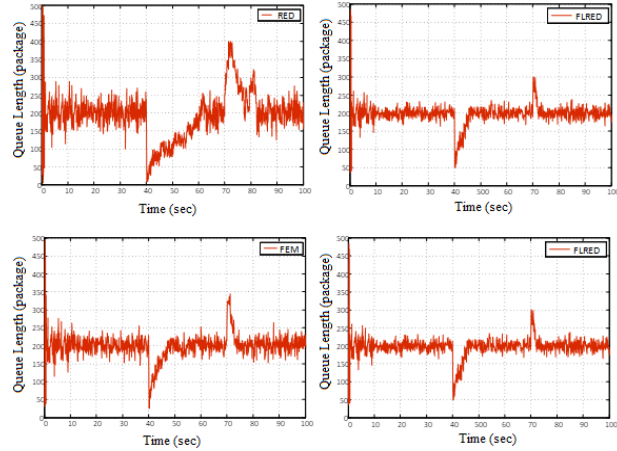
Figure 14. Ability to respond of RED, FEM and FLRED